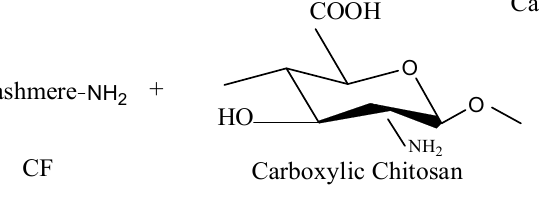
Figure 7. The schematic diagram of reaction between the carboxylic chitosan and CF.